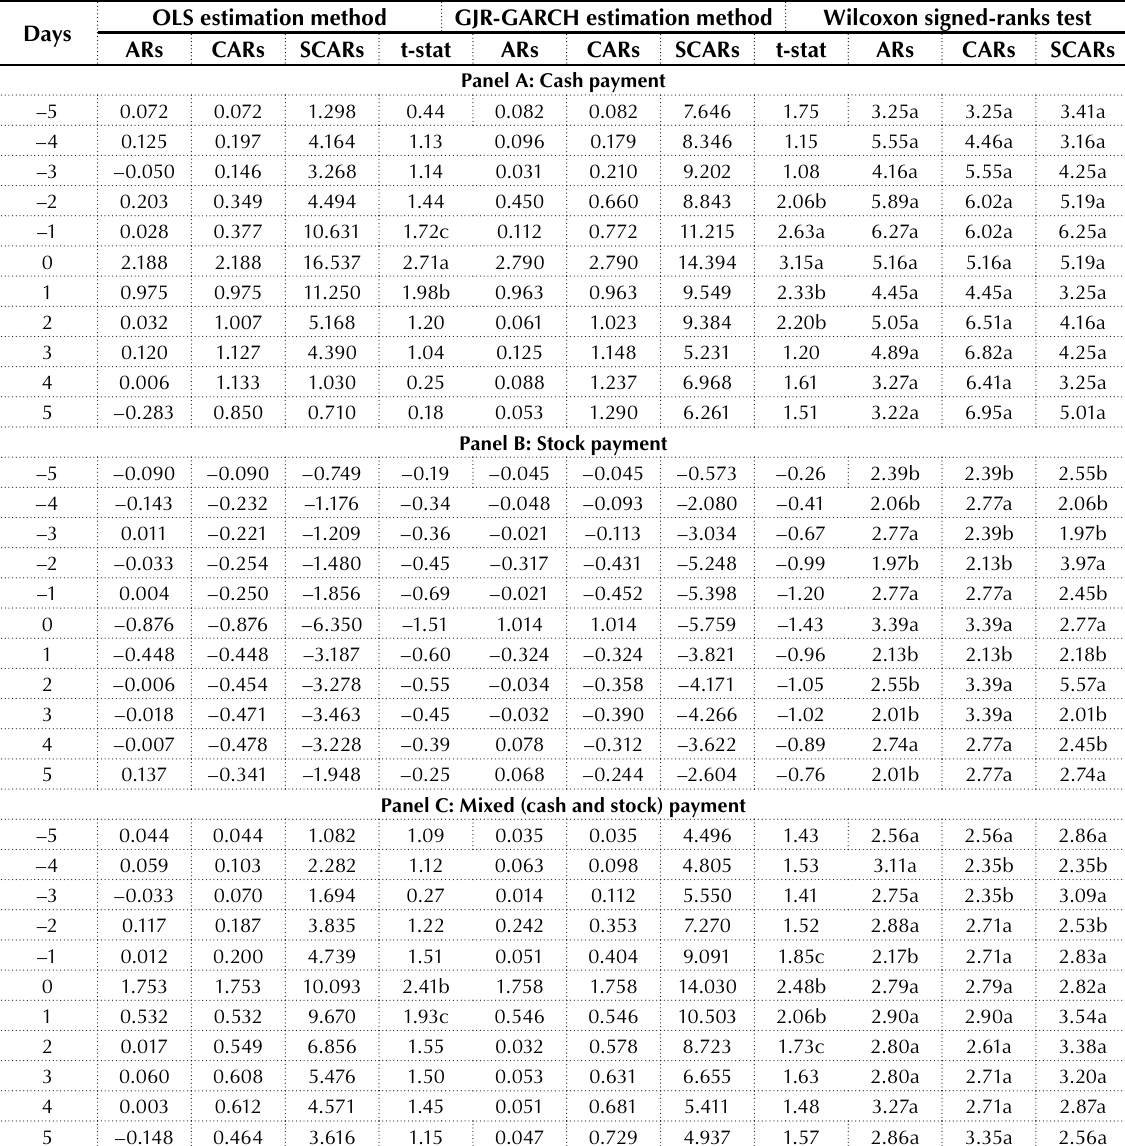
Table 5. Average AR measures around announcements for targets by payment method OLS estimation method GJR-GARCH estimation Days